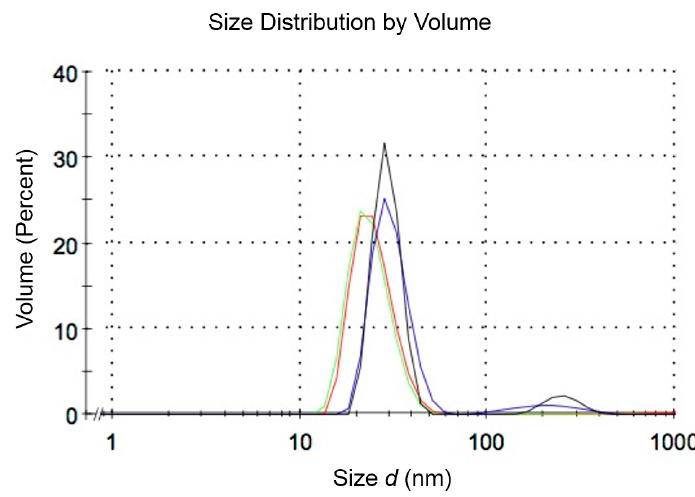
Figure 12. Flow profile in the device used to manufacture the nanoparticles. Run 1 ( A , B ) was done with 0.03 mL/h (Phenol-red) and 1 mL/h (NaOH) and for Run 2 ( C , D ) the flow rates 1 mL/h (Phenol-red) and 4 mL/h (NaOH) was used. The pitch length is 2.24 mm. The scale bar represents 200 μ m.